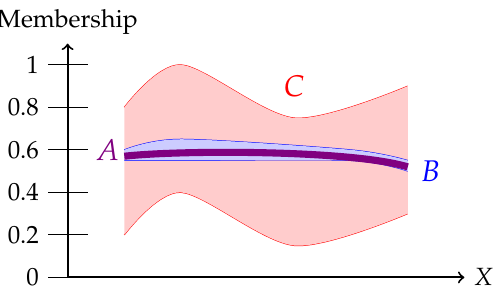
Figure 15. Related IVFSs with different